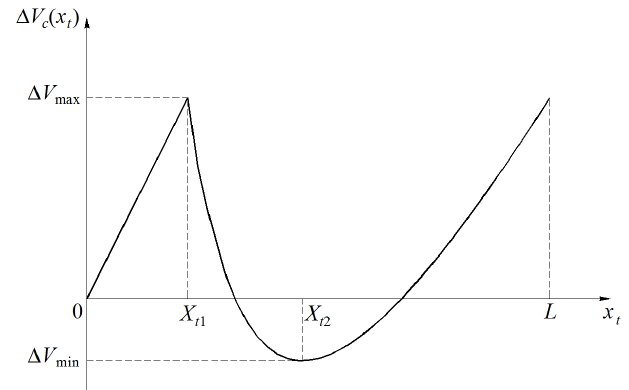
Figure 6. Voltage drop of EDLCs as a function of the